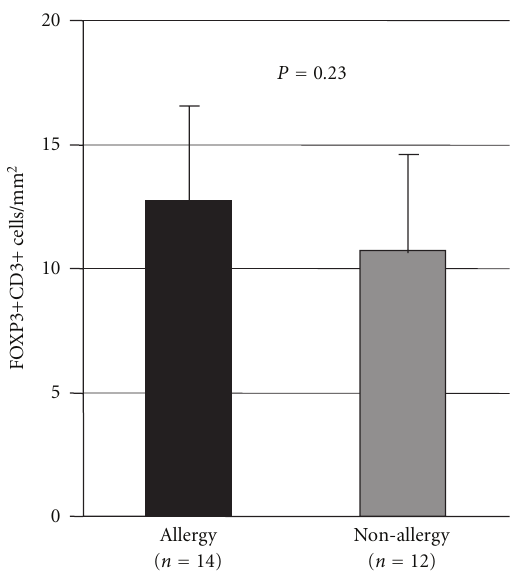
Figure 3: The number of FOXP3+CD3+ cells in allergic and non- allergic nasal mucosa by means of double immunofluorescence staining for FOXP3 protein and CD3. There are no significantly di ff erences between the groups in terms of the number of FOXP3+ CD3+ cells.